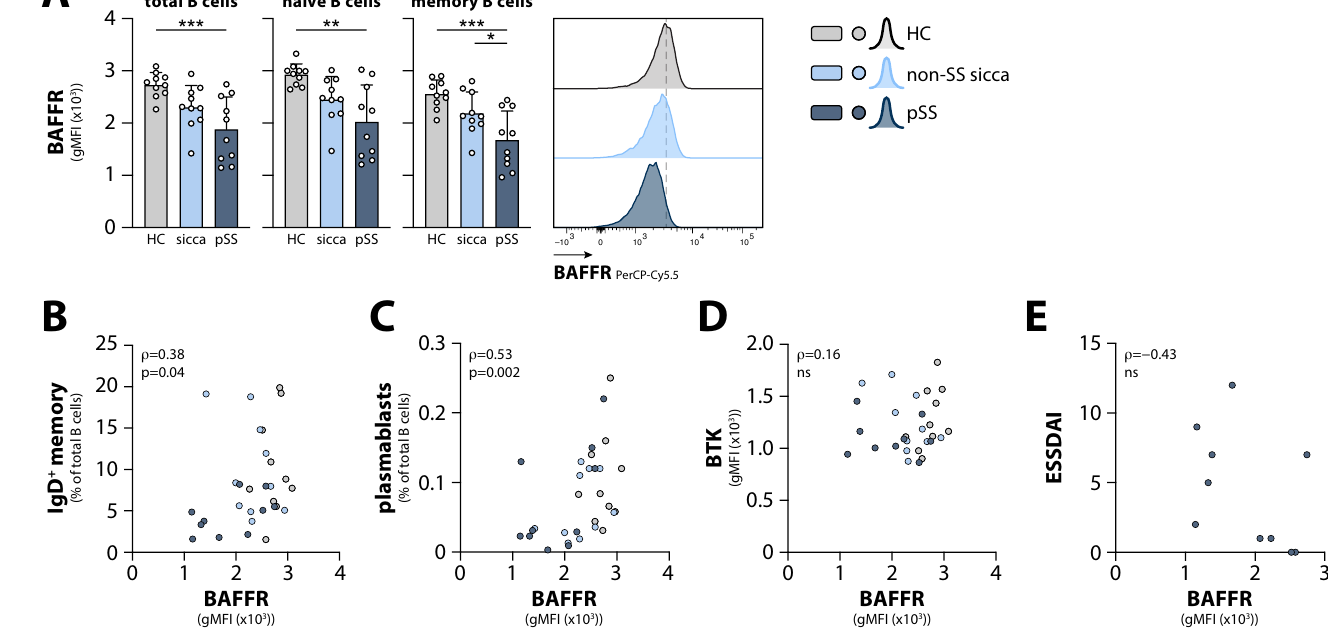
Figure 4. BAFFR expression on circulating B cells from non-SS sicca patients, pSS patients, and HCs. ( A ) BAFFR surface expression on total, naïve, and memory B cells. Representative histograms are shown for total B cells. Bars indicate mean + SD. ( B – E ) Spearman’s rank correlation analysis between surface BAFFR expression on total B cells and ( B ) proportion of IgD + memory B cells, ( C ) proportion of plasmablasts, ( D ) intracellular BTK levels in total B cells from non-SS sicca patients, pSS patients and HCs, and ( E ) ESSDAI scores from pSS patients. *** p < 0.001, ** p < 0.01, * p < 0.05 by Kruskal-Wallis test with Dunn’s correction for multiple